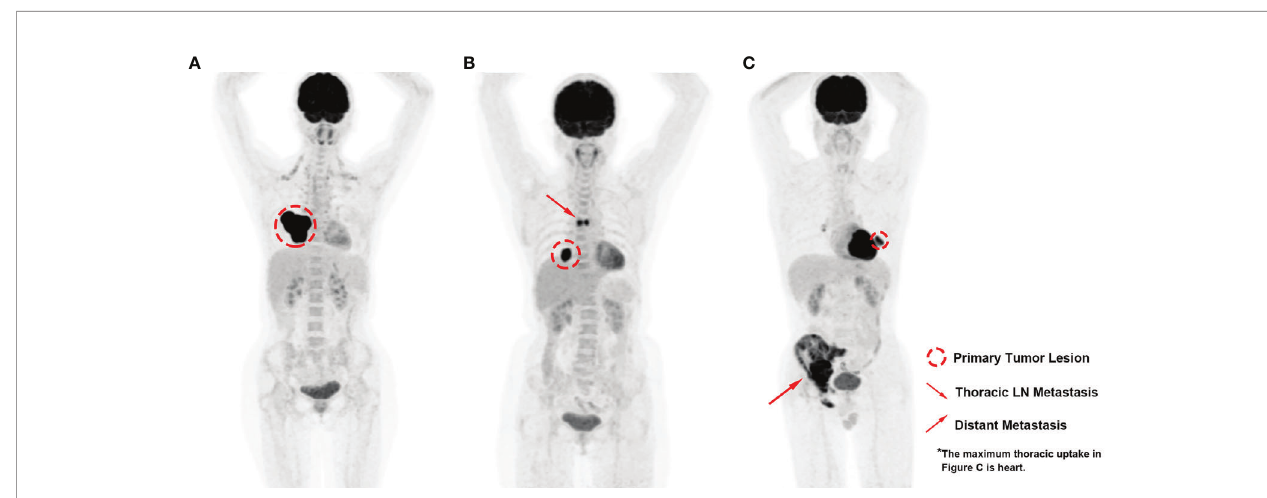
FIGURE 1 | PET images of pulmonary LELC patients with various lesion distribution patterns. (A) High metabolic volume of primary lesion without regional or distant metastasis; (B) Moderate metabolic volume of primary lesion with moderate metabolic volume of thoracic lymph-node metastasis; (C) Low metabolic volume of primary lesion with high metabolic volume of distant